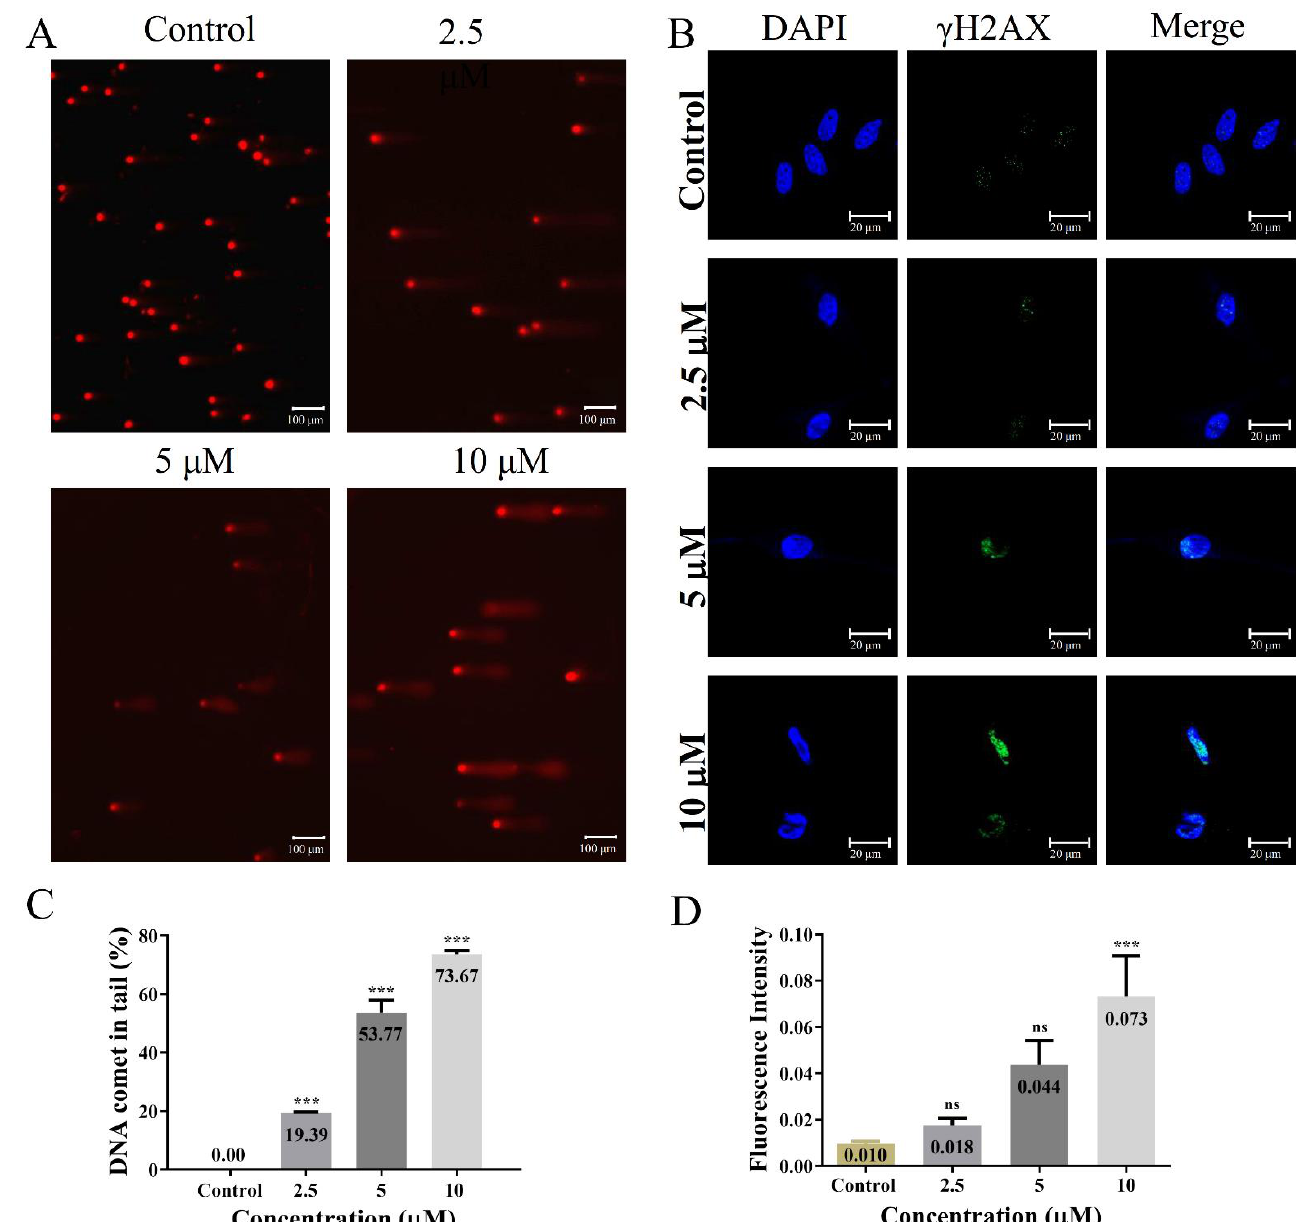
Figure 6. Elevated levels of DNA damage in MCF-7 Human breast cancer cells treated with complex 1 . ( A ) Representative images of MCF-7 cells treated with complex 1 (0, 2.5, 5, and 10 μM) for 72 h for comet assays. ( B ) Quantification of the tail moment using comet assays of cells treated as in ( A ); n = 3; error bars, SD. p values were calculated using an unpaired two-tailed t test. ( C ) Representative images of MCF-7 cells treated with 1 (0, 2.5, 5, and 10 μM) for 72 h before processing for immunofluorescence staining with anti- γ H2AX antibody (green). DNA was counterstained with DAPI (blue). ( D ) Corresponding quantification of (C) shows the normalized mean fluorescence intensity of γH2AX within the nucleus. (*** p < 0.001; n.s. represents not significant).